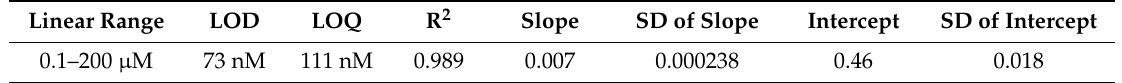
Table 4. Analytical parameters of the calibration straight of biosystem